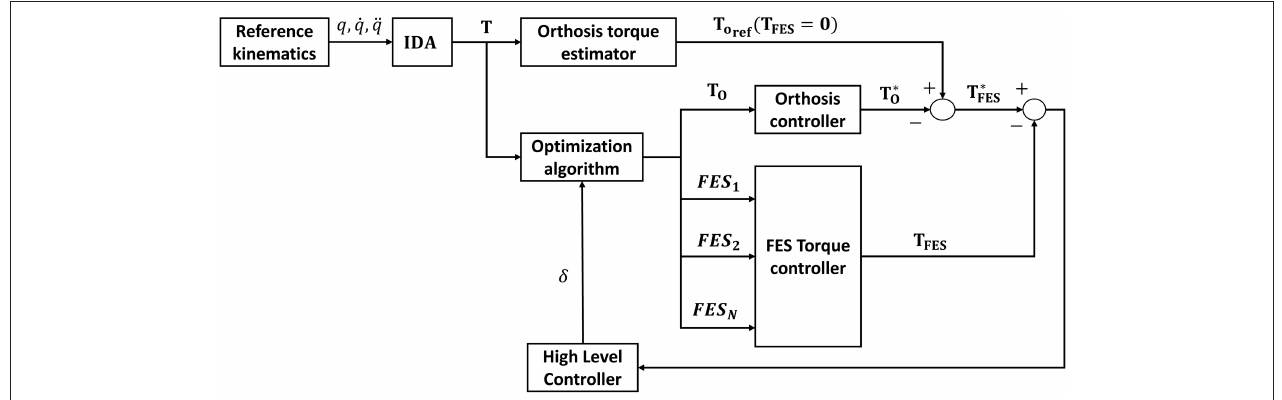
FIGURE 10 | Control architecture of the cooperative